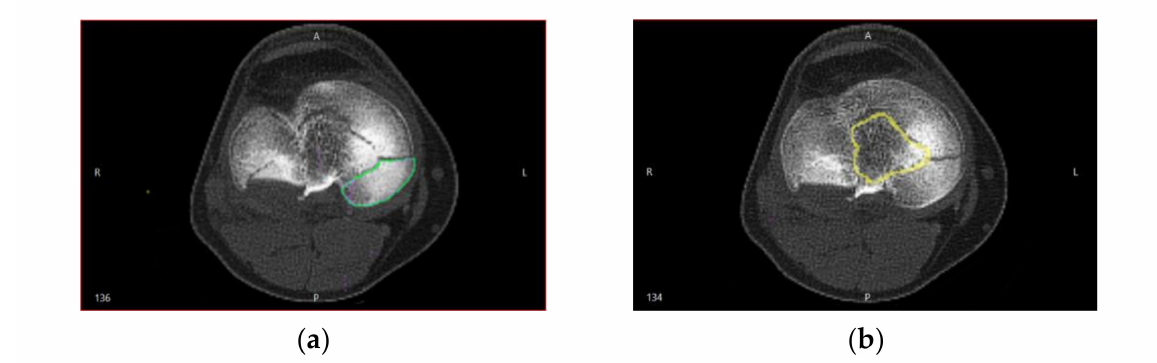
Figure 2. Comminutive tibial fractures shown in CT sections used in the process of the bone fragment fracture surfaces identification. The bone fragment segmented surface is delimited in color: ( a ) the inside of the bone has a higher intensity than that of the cortex; ( b ) the estimated surface segmentation is at a distance from the cortical